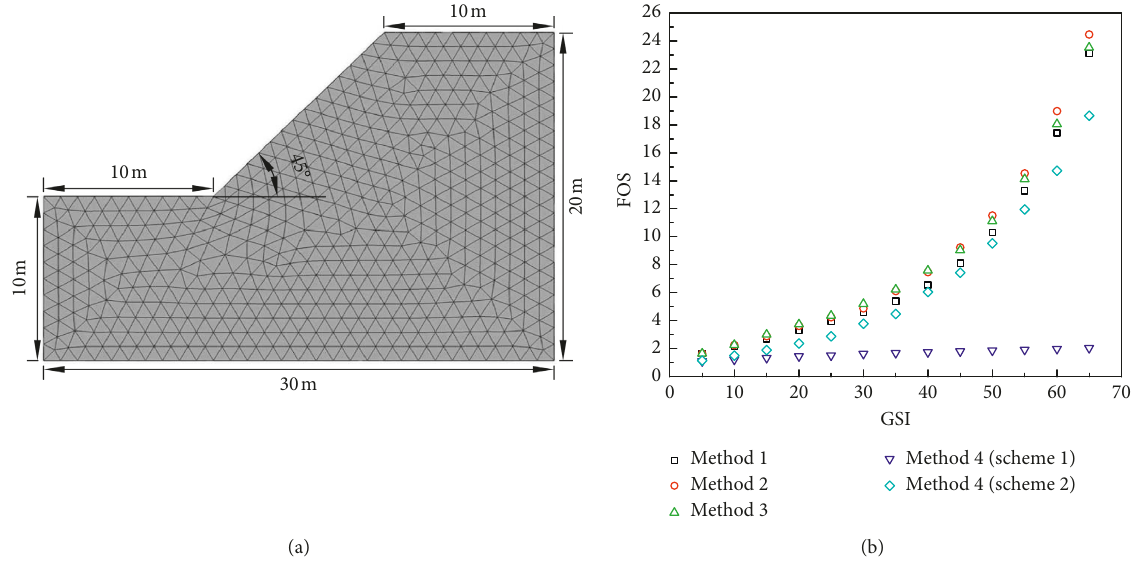
Figure 4: The safety factors of the rock slope. (a) The illustration of the rock slope and (b) the relationship between FOS and GSI.